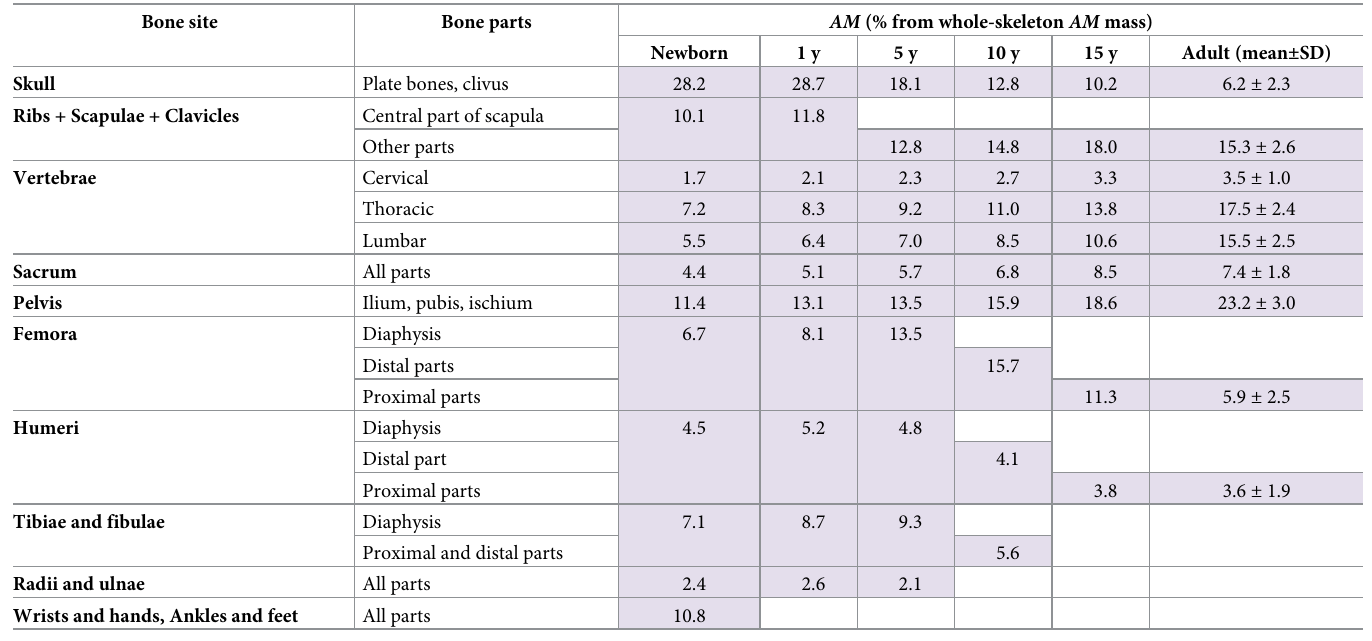
Table 1. Main hematopoietic sites of human skeleton in different ages and distribution of AM for newborns and pre-adults [22] and for adults [23]. Bone